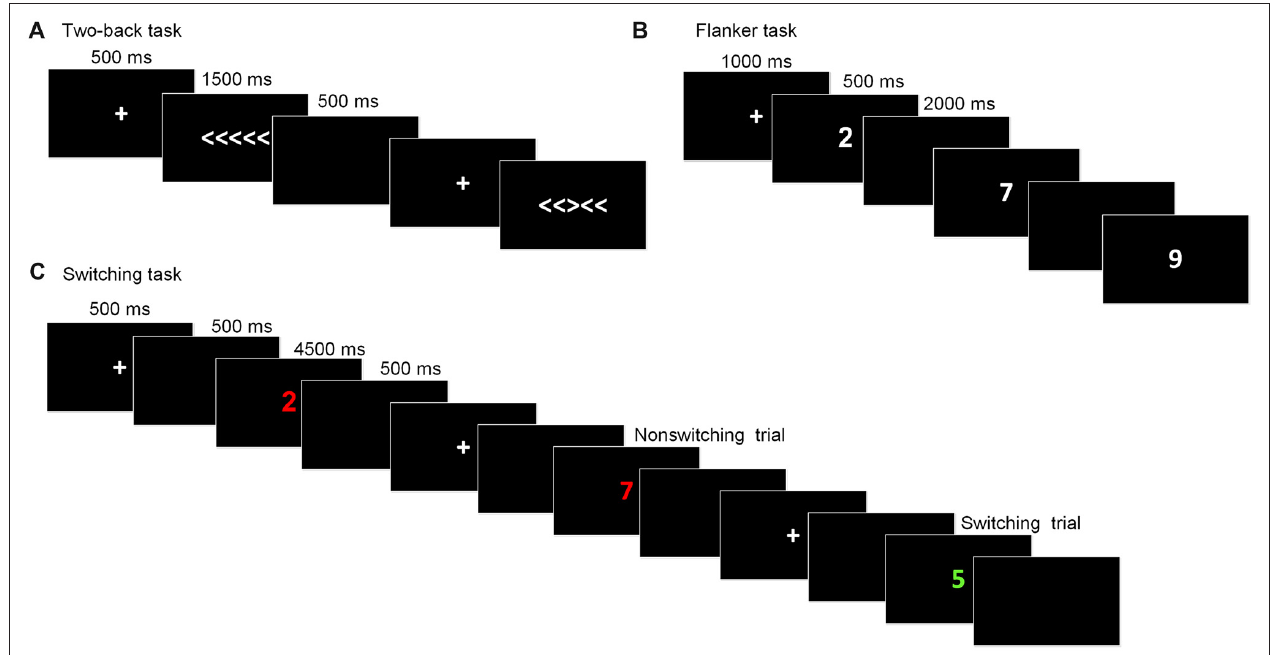
FIGURE 2 | Schematic of the executive function paradigms. (A) Flanker task; (B) Two-back task; (C) Switching